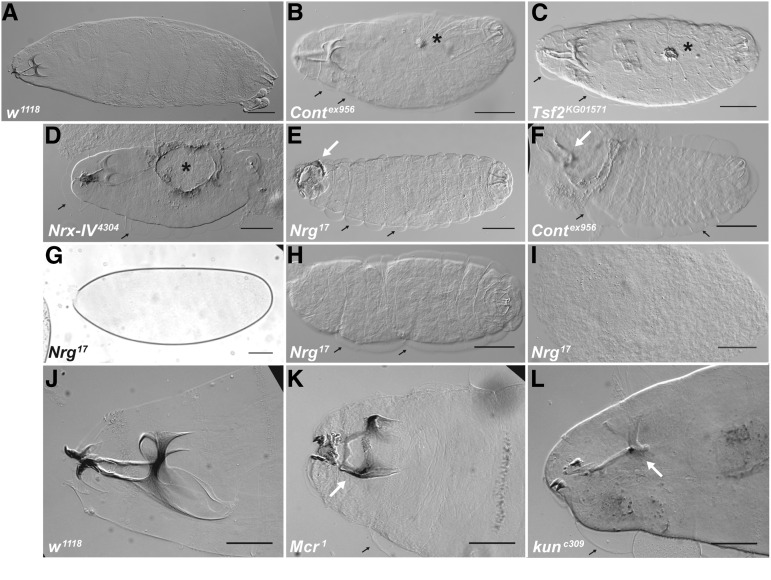
Loss of function mutations in SJ genes result in embryonic lethality with defects in head involution and dorsal closure. DIC photomicrographs (A–F, H–L) and a brightfield photomicrograph (G) of cuticle preparations of w1118 (A and J), Contex956 (B and F), Tsf2KG01571 (C), Nrx-IV4304 (D), Nrg17 (E and G–I), Mcr1 (K), and kunec309 (L). Anterior is to the left and dorsal is up or facing. Defects in dorsal closure are indicated by cuticular scabs or holes on the dorsal surface (asterisks in B–D), whereas defects in head involution vary from completely uninvoluted head structures (arrows in E and F), to incomplete head involution where head skeletal structures are compressed anteriorly (arrow in K), to underdeveloped head skeleton (arrow in L points to a head skeleton lacking most of the dorsal and ventral processes). A number of embryos showed an “Empty Cuticle” phenotype (G), that when devitellinized varied from having a thin cuticle barely capable of holding the embryo together (H), to little or no cuticle resulting in disorganized mass of cells (I). Note the cuticle has separated from the epidermis in all of the mutant animals (small black arrows), but not in the w1118 animals. Scale bars = 100 μm in A–F, H, and I, 60 μm in G, and 50 μm in J–L.